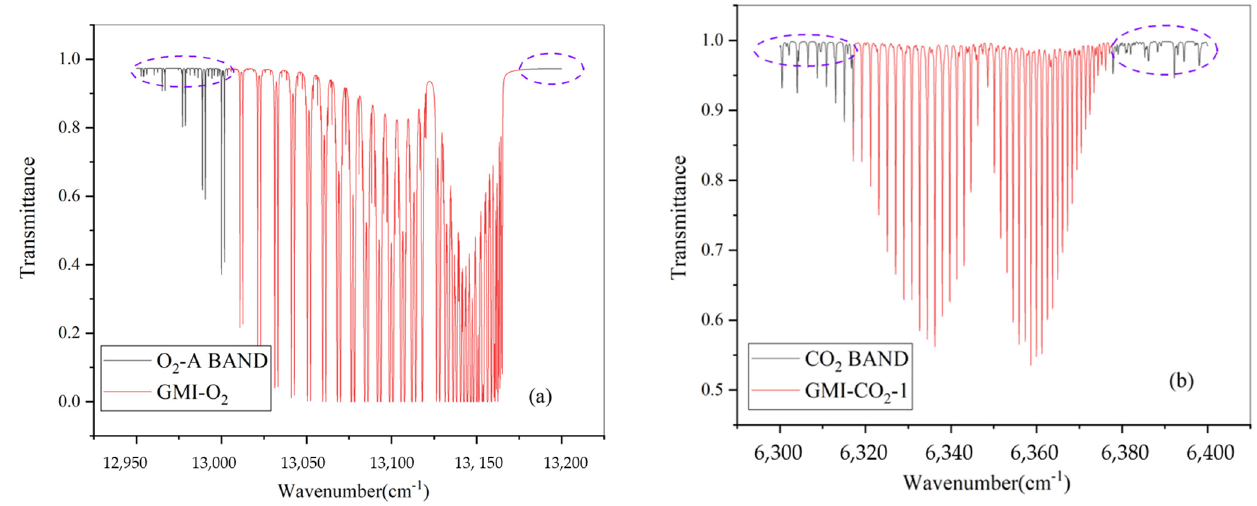
Figure 17. Spectral range of the O 2 ( a ) and CO 2 − 1 ( b ) channels.